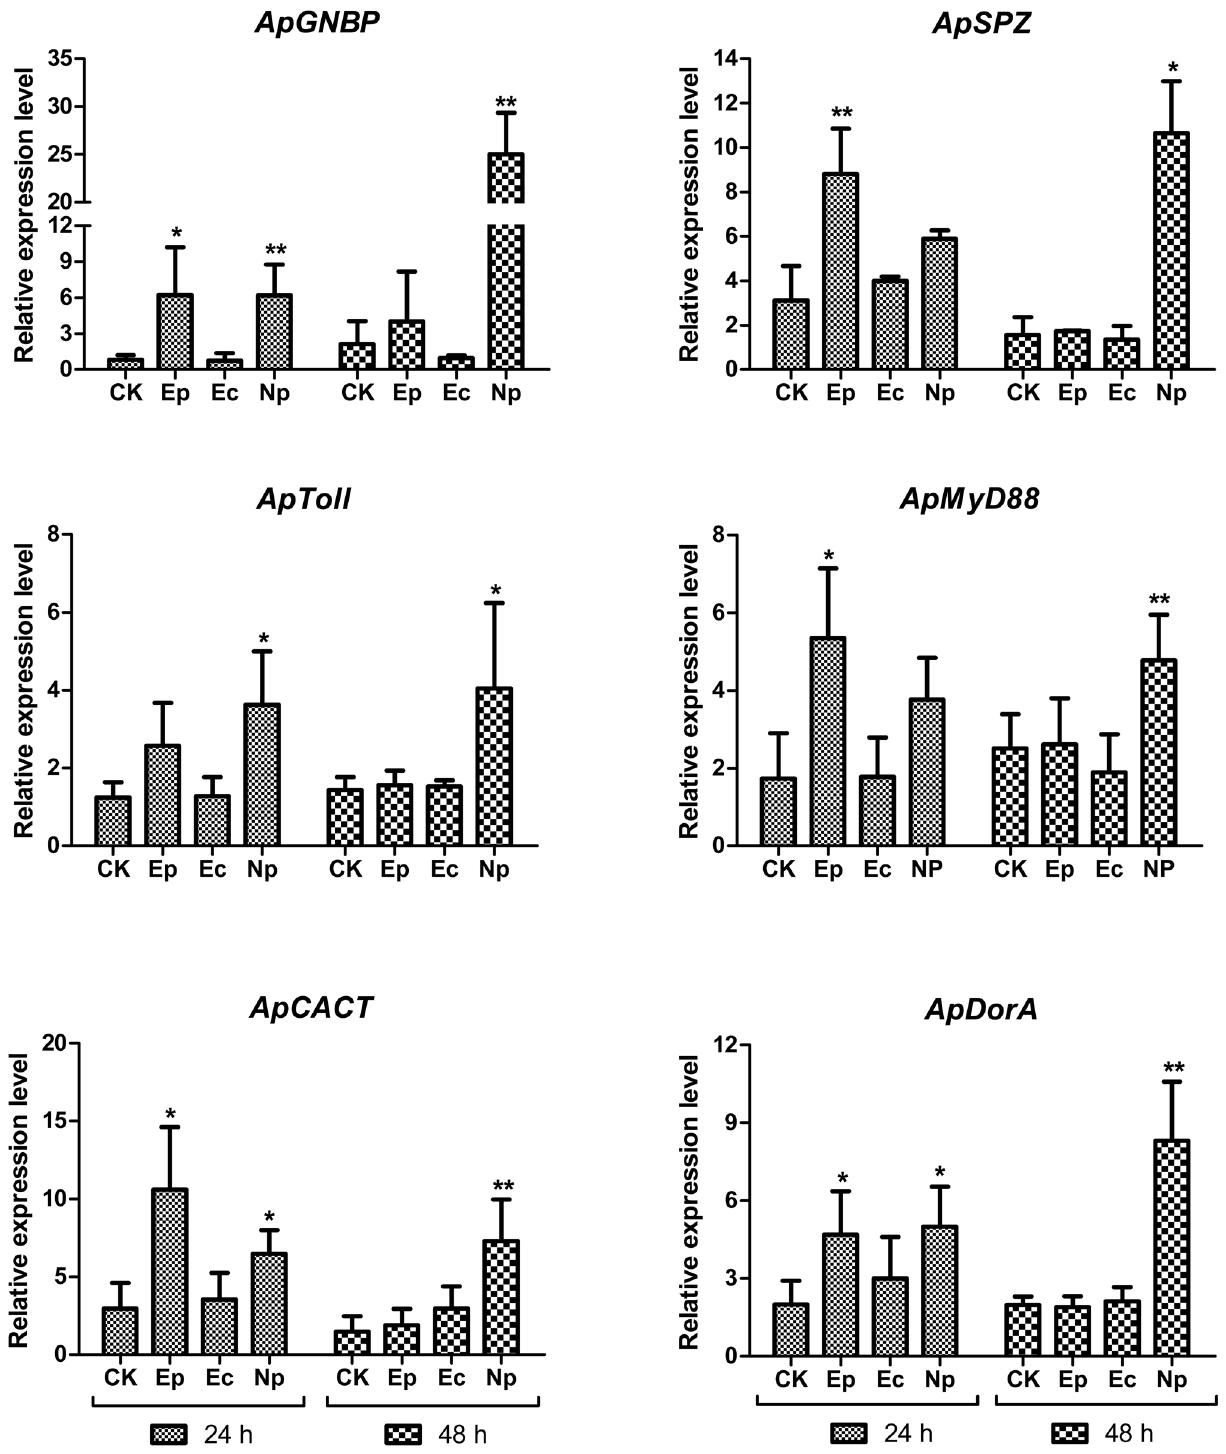
Fig 5. Relative mRNA levels of genes in the Toll pathway were detected by qRT-PCR in A . pernyi treated with pathogenic microorganisms. The fifth instar larvae were inoculated by oral feeding with Escherichia coli (Ec), Enterococcus pernyi (Ep), or Nosema pernyi (Np) on the first day, and larvae fed sterile water were used as control samples (CK). Fat bodies dissected from each group for RNA extraction 24 h and 48 h after inoculation were used for qRT-PCR testing.